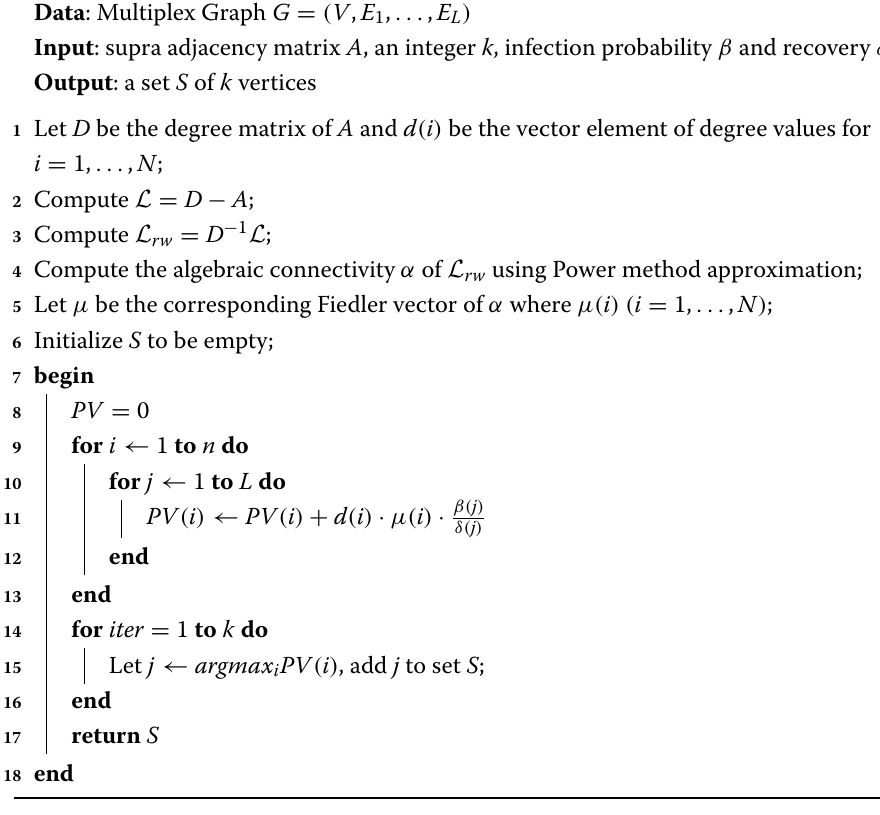
Algorithm 1: M ULTIPLEX S HIELD - M ( for Multiplex-Based Protection